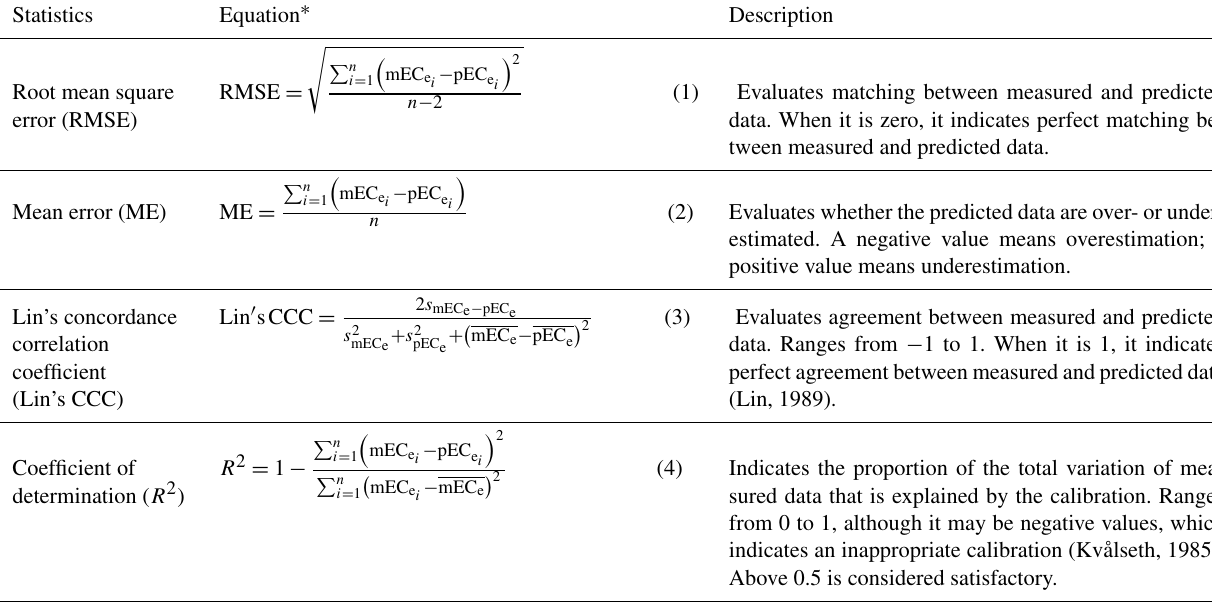
Table 1. Description and equations of the statistical indicators used to evaluate the prediction ability of the regional calibration in this work. Statistics Equation ∗ Description